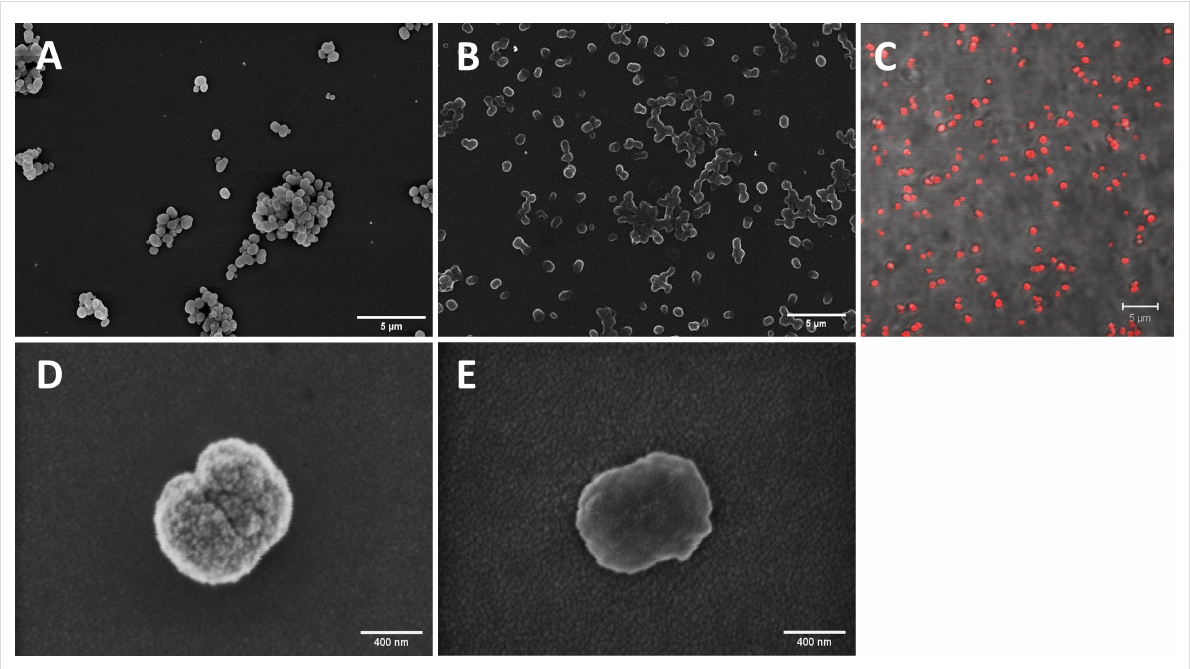
Figure 1: Microscopic images of HbMP. (A, D) SEM images of dried and adherent particles after precipitation with carbonate template. (B, E) SEM images of dried and adherent final HbMP after precipitation, cross-linking, dissolution, and washing. (C) CLSM image with autofluorescent HbMP in suspension. Scale bars: A, B, C = 5 µm, D, E = 400